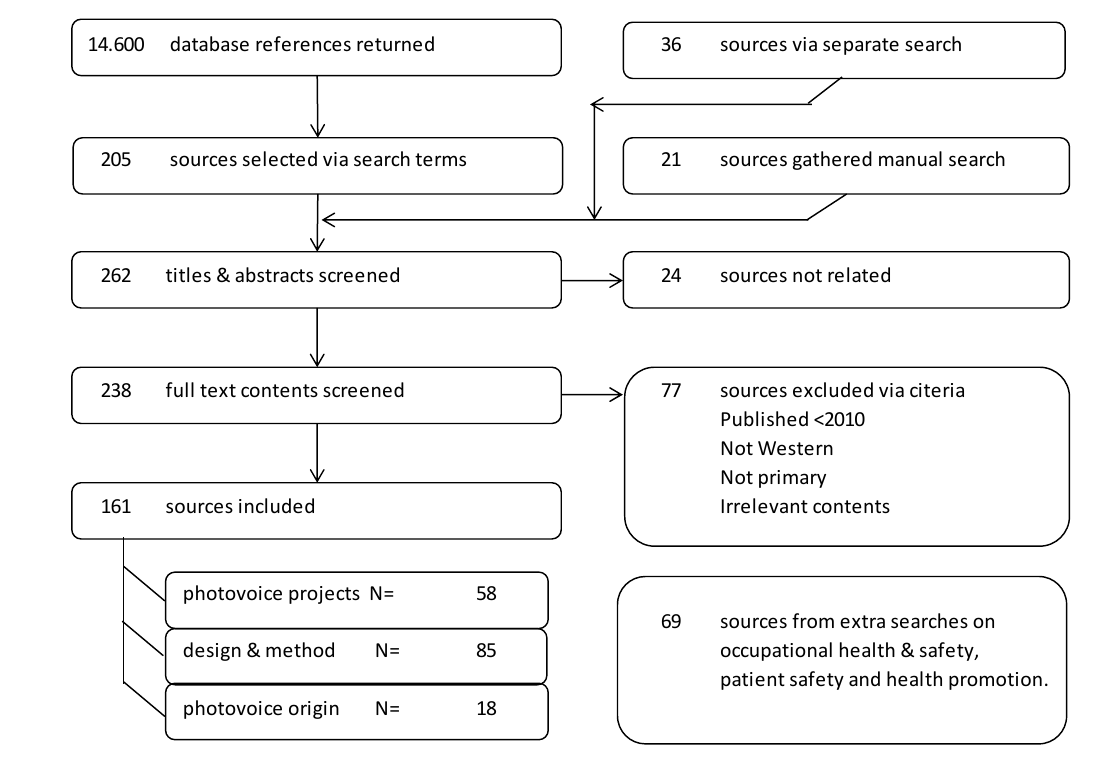
Figure 1. Flowchart of literature screening process [28,29].